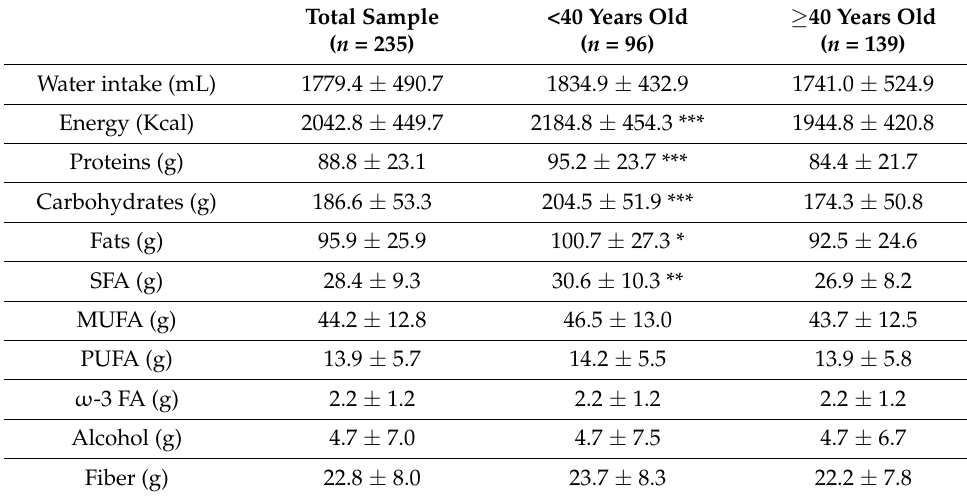
Table 2. Daily water, energy, and macronutrient intake in the total sample.